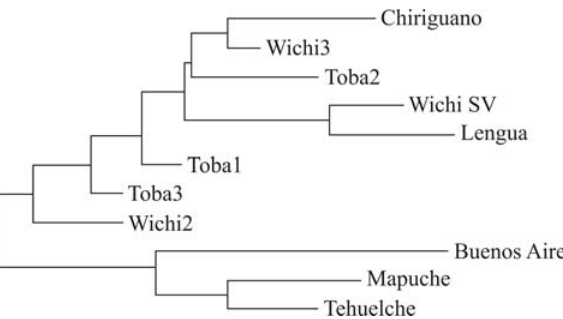
Figure 2 - NJ dendrogram of the genetic distances (DA) among the ana- lysed populations. For identifications and references, see Table